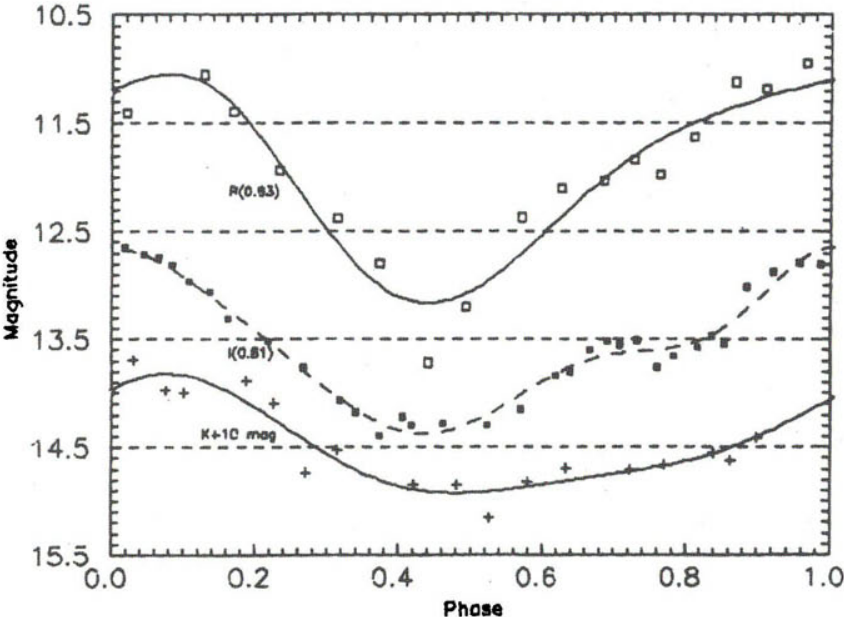
Fig. 2. Light curves of the periodic component of light variation of V366 Lac in the R (0.63), / (0.81) and K passbands. To the K values a constant of 10 mag is added. The data are average R (0.63) and K values for the phase bins of 0.05P. For most of / (0.81) values the phase bins are divided in two parts. Designations are the same as in Fig.